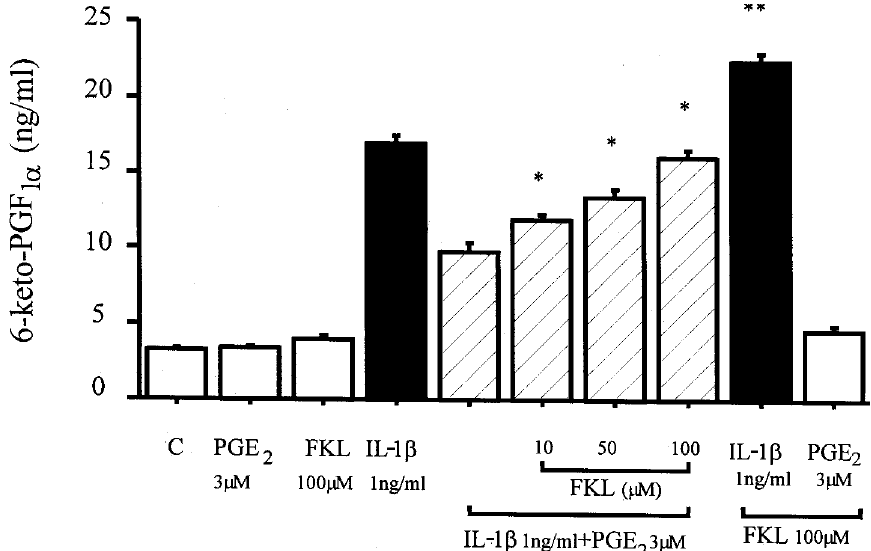
FIG. 5. The effects of forskolin (10, 50 or 100 m M) on COX activity in IL-1 b (1ng/ml) plus PGE 2 (3 m M) treated HUVEC. COX activity was measured by the formation of 6-keto-PGF 1 in the presence of exogenous arachidonic acid (10 m M; 10min). Data a are expressed as mean±SEM of 12 determinations from at least four separate experimental days. * P < 0.05 when compared to IL-1 b plus PGE 2 treated HUVEC at 24h. ** P < 0.05 when compared to IL-1 b treated HUVEC at